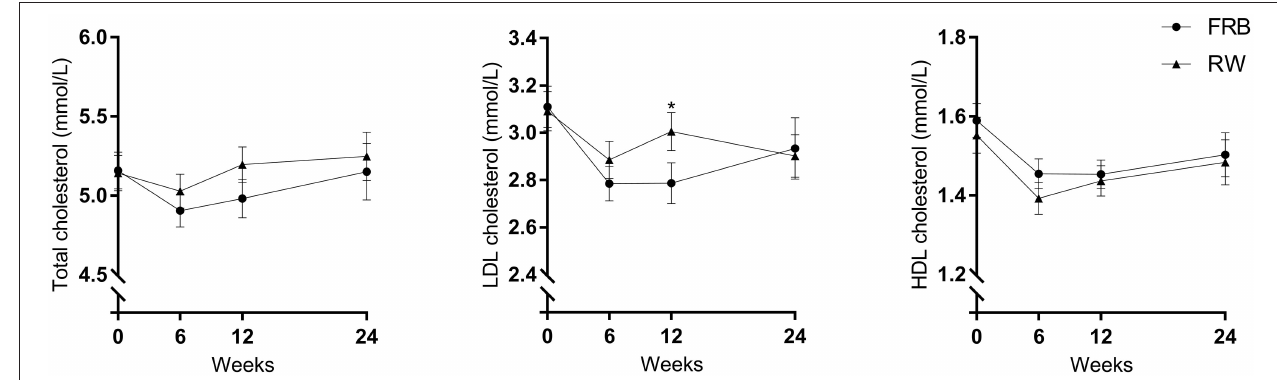
FIGURE 3 | Plasma total cholesterol, low density lipoprotein (LDL) cholesterol and high density lipoprotein (HDL) cholesterol at base-line, after 6 and 12 weeks of intervention and 12 weeks post intervention (week 24) in the fermented rye bran (FRB) and in the refined wheat (RW) group among all completed cases. Data is mean ± SEM. Statistically significant differences are indicated by * p < 0.05.